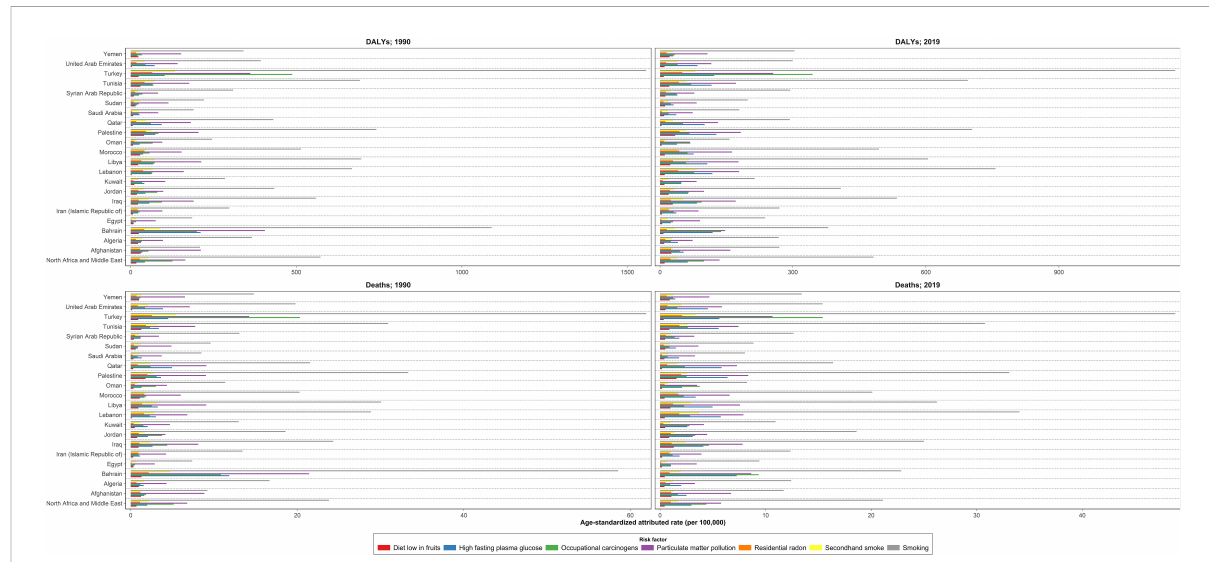
FIGURE 4 Age-standardized DALYs and death rates due to tracheal, bronchus, and lung cancer attributed to risk factors in the region and countries, 1990 and 2019 DALYs = disability-adjusted life